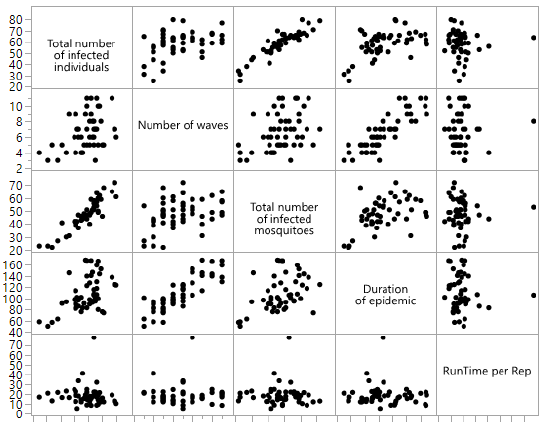
Figure 10. The relation between the number of waves vs. the duration of the epidemic per parame- ter.